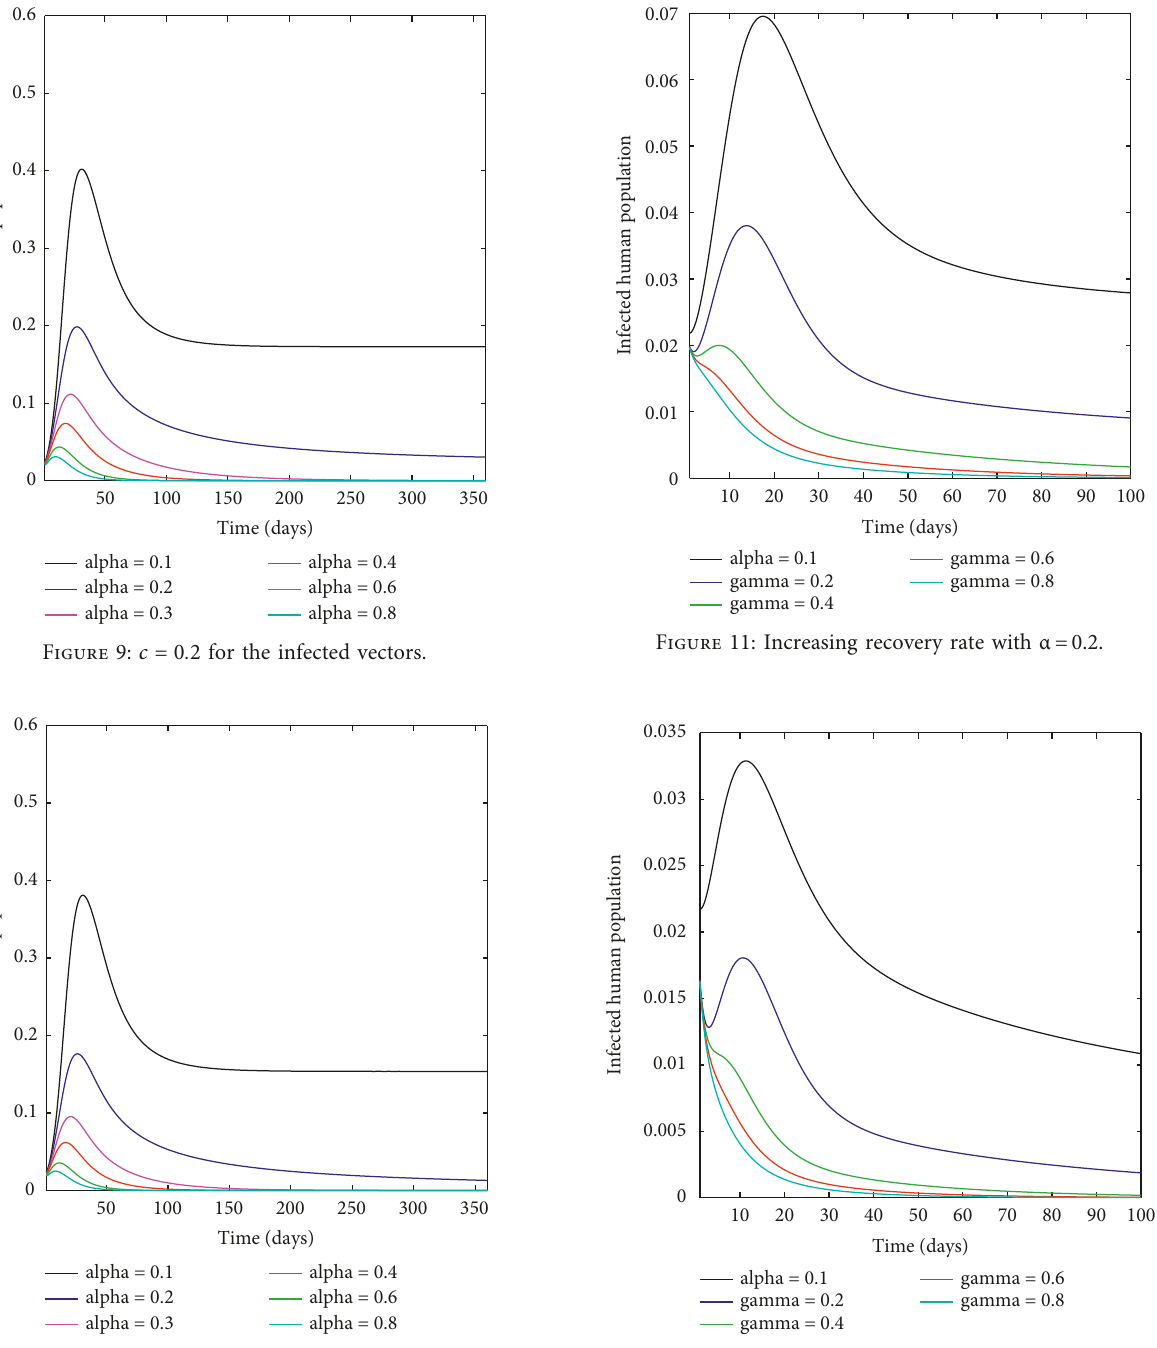
Figure 12: Increasing recovery rate with α �